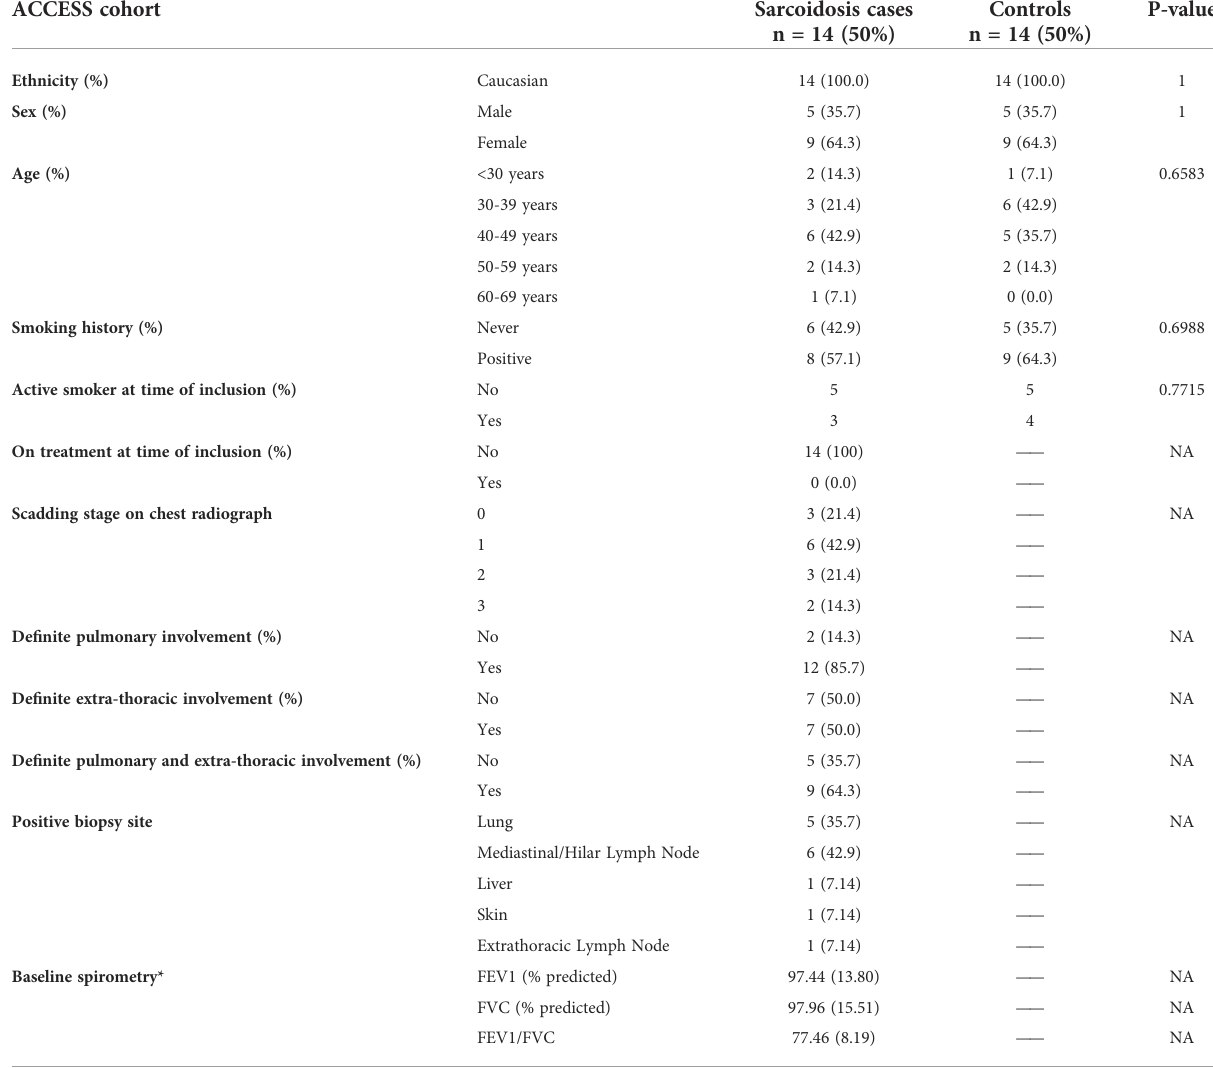
TABLE 1 Baseline characteristics of sarcoidosis cases and matched controls in the ACCESS cohort based on responses or results reported on ACCESS Study data forms. ACCESS